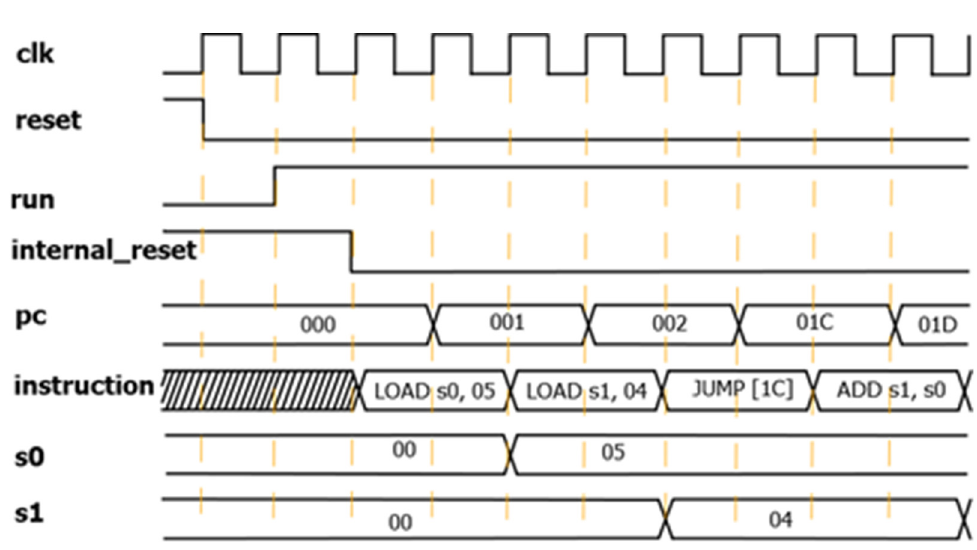
Figure 5. Tracing PicoBlaze instruction execution after a reset signal is asserted.